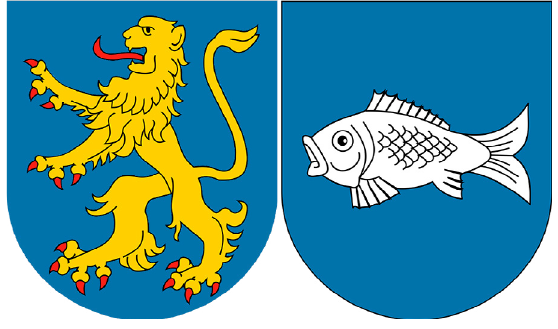
Figure 6. The arms of Lampartopol and